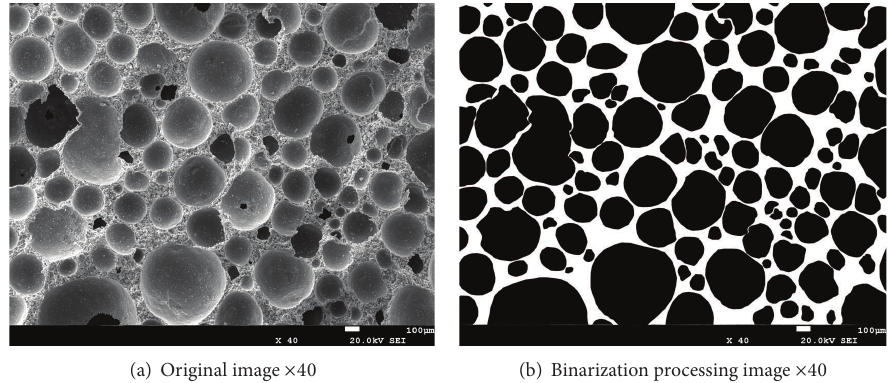
Figure 3: SEM images of the foamed concrete specimens before and after